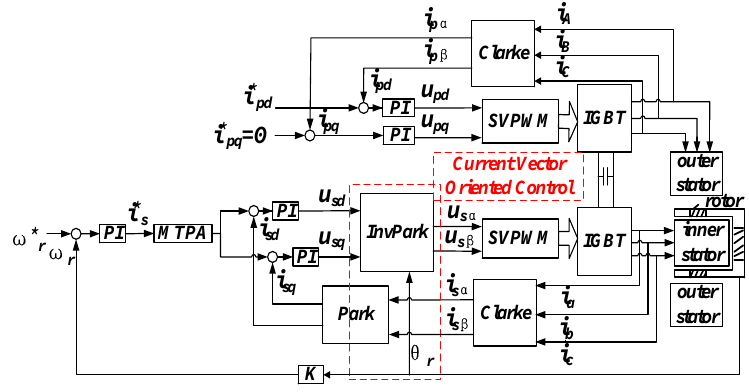
Figure 8. DC excitation control method.